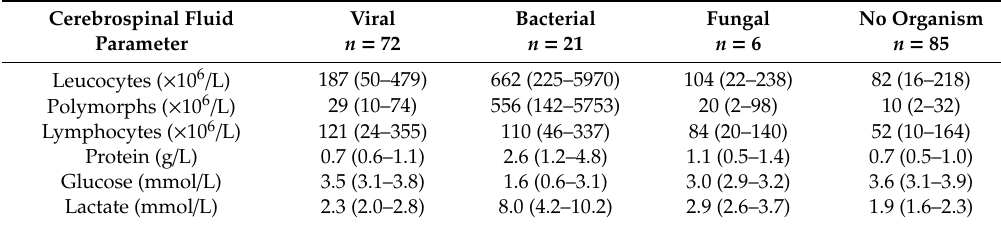
Table A2. Cerebrospinal fluid findings by infection type (median and interquartile